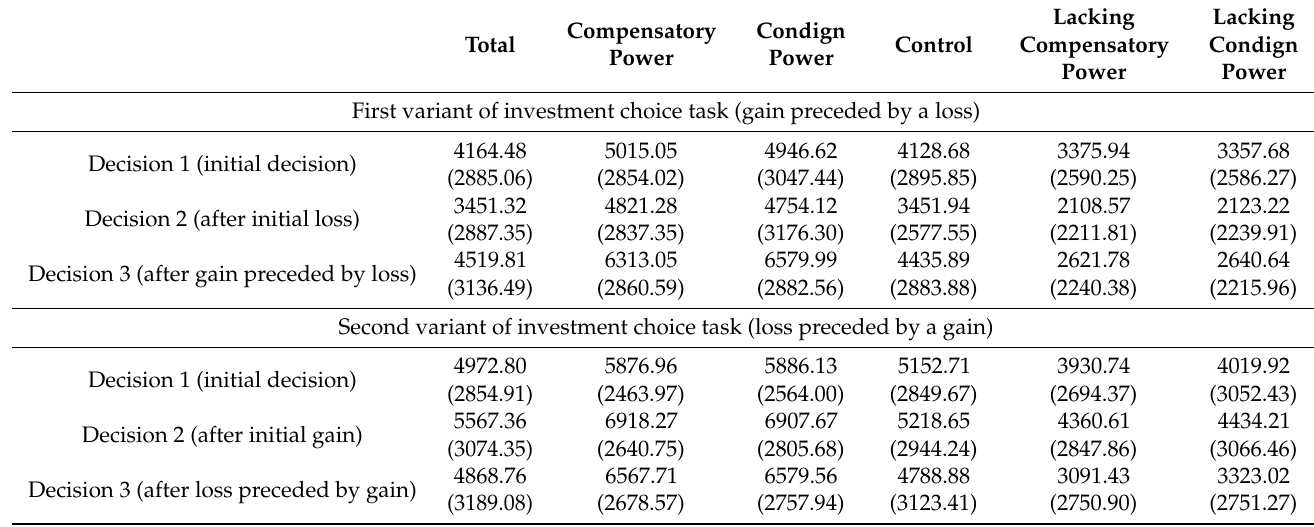
Table 1. Descriptive statistics in the total sample and experimental groups. Compensatory Total Power